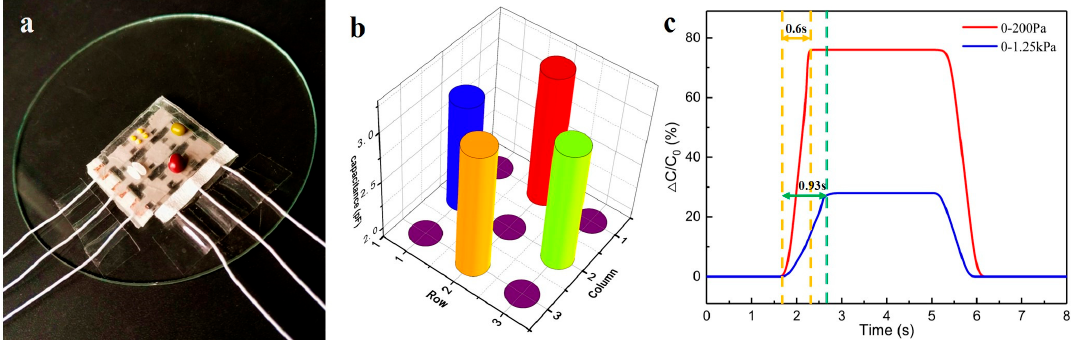
Figure 7. Sensitivity test. ( a ) Low-load sensor array; ( b ) histogram of low detection response; ( c ) instantaneous response test curve.